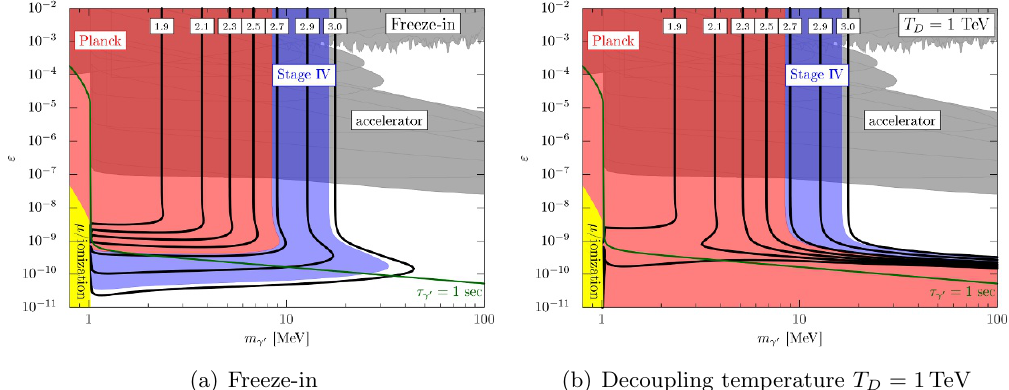
Figure 4 . The contour plots of N e(cid:11) on the m (cid:13) 0 - " plane. The left panel corresponds to the freeze-in scenario, while the right panel to the early decoupled scenario. The red region shows the present Planck constraint N e(cid:11) = 2 : 99 +0 : 34 (95%) [12]. The blue region shows that the sensitivity of the 0 : 33 (cid:0) stage IV CMB experiment (cid:14)N e(cid:11) = 0 : 06 [13]. The yellow shaded region is excluded by the constraint on the CMB distortion ( (cid:22) distortion) [30] and the e(cid:11)ects on the reionization history [31]. The green line corresponds to the parameters where the lifetime of the dark photon is (cid:28) (cid:13) = 1 sec. The 0 gray shaded region is the compilation of the constraints from the beam dump and the collider experiments in ref. [8], NA64 [51] and the electron g (cid:0) 2 constraint